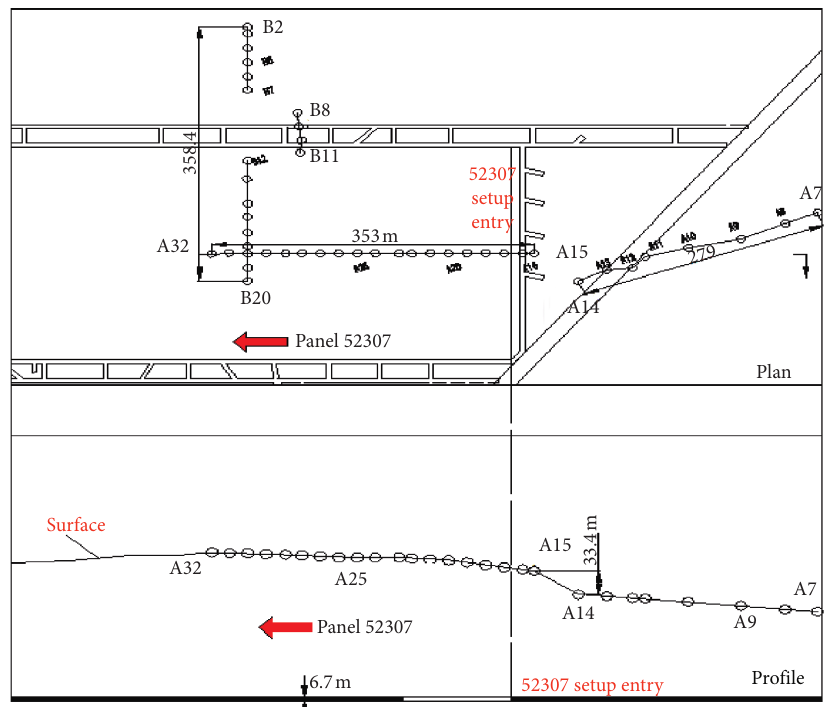
Figure 8: Horizontal section diagram of the observation